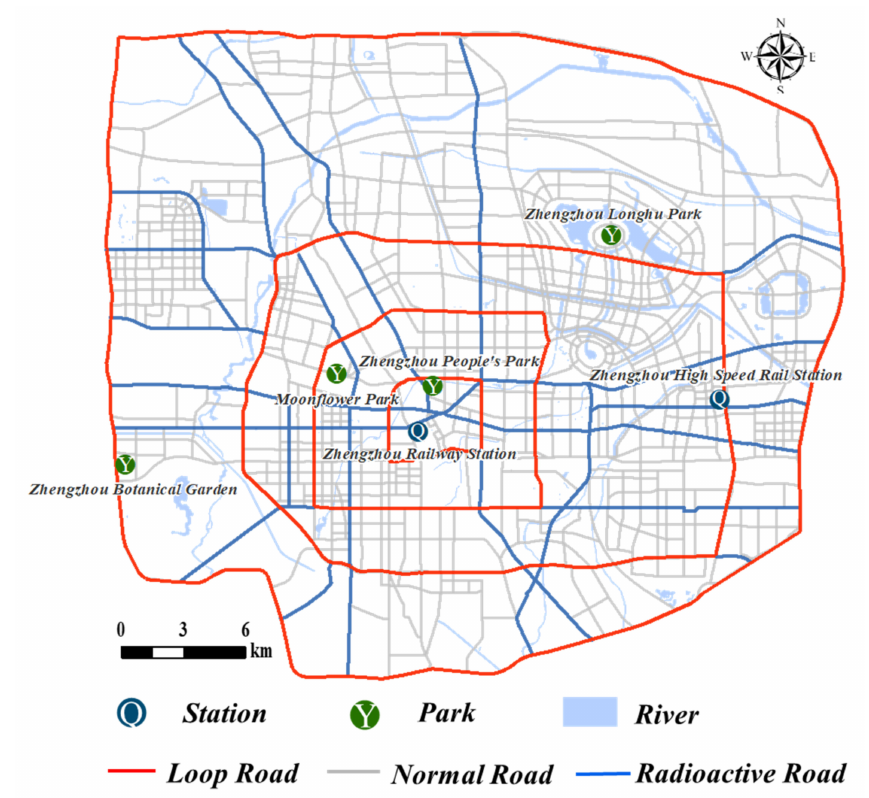
Figure 1. Study area of Zhengzhou, China. Table 1. Statistics on Zhengzhou “7.20” Rainstorm in different short